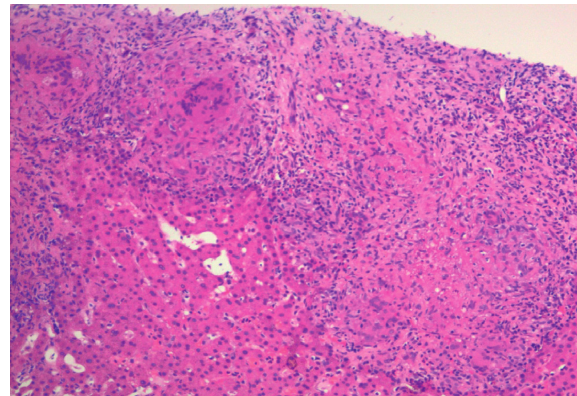
Figure 4: Thyroid nodule core biopsy pathology report revealing non-necrotizing granulomatous infiltration consistent with sar- coidosis. Trichrome stain showed no significant fibrosis, and iron stain was negative for iron